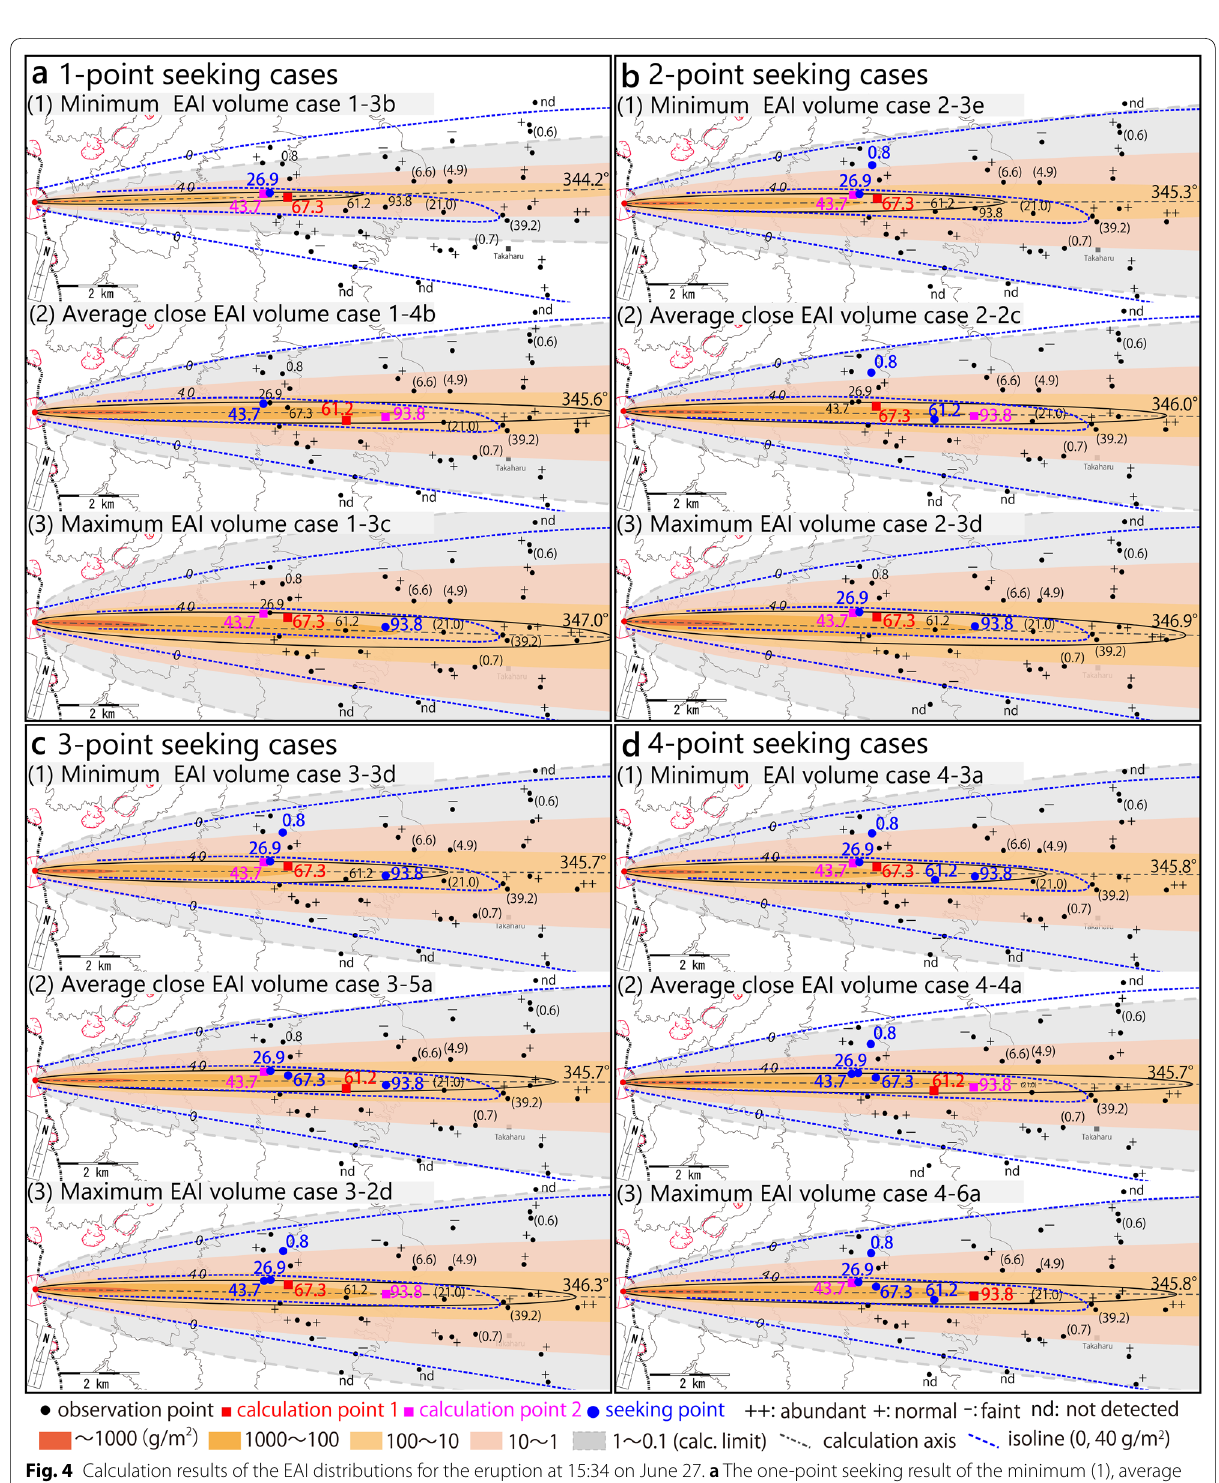
Fig. 4 Calculation results of the EAI distributions for the eruption at 15:34 on June 27. a The one-point seeking result of the minimum (1), average close (2), and maximum (3) EAI volume cases. b The two-point seeking result of the minimum (1), average close (2), and maximum (3) EAI volume cases. c The three-point seeking result of minimum (1), average close (2), and maximum (3) EAI volume cases. d The four-point seeking result of minimum (1), average close (2), and maximum (3) EAI volume cases. Numerical values are the amounts of ashfall (g/m 2 ) to the points and axis angle (°) of the calculation. Blue dashed lines are the 0 and 40-g/m 2 isolines obtained via the field survey, and the black line is the 40-g/m 2 isoline obtained via the EAI calculation. Results of cases are shown in Additional file 3: Table